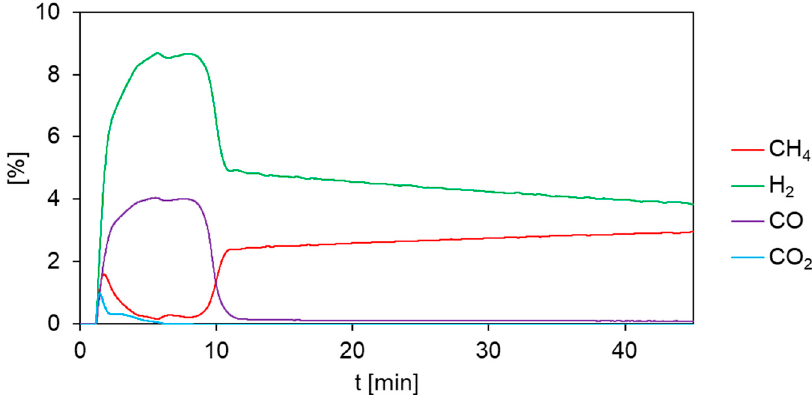
Figure 11. Perovskite reduction and CH 4 decomposition at 970 °C.